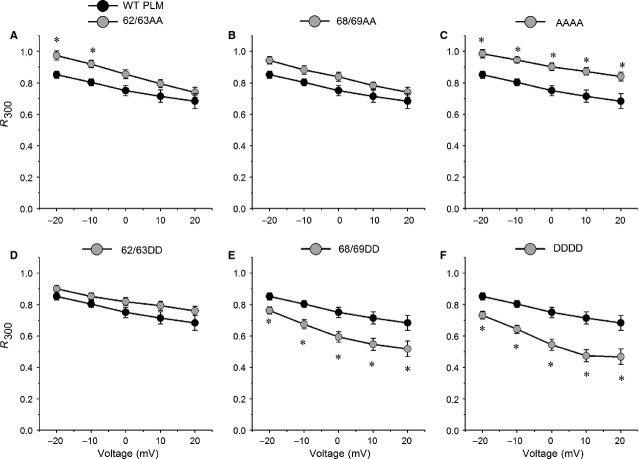
S68T69 phosphorylation affects PLM-induced increases in voltage-dependent inactivation (VDI). R300, the fraction of peak current measured at the end of 300-msec. voltage steps to the indicated voltages, was plotted versus voltage (representative currents are depicted in Fig.2). (A) R300 for 6263AA (n + 7) was significantly larger than WT PLM (n + 10) at −20 and −10 mV, P < 0.05. (B and D) Both of R300 for 6869AA (n + 6) and 6263DD (n + 8) was slightly larger than WT PLM at all observed potentials, P > 0.05. (C) R300 for AAAA (n + 7) was significantly larger than WT PLM at all observed potentials, P < 0.05. (E and F) Both of R300 for 6869DD (n + 6) and DDDD (n + 7) was substantially smaller than WT PLM at all observed potentials, P < 0.05. *P < 0.05 versusWT PLM.